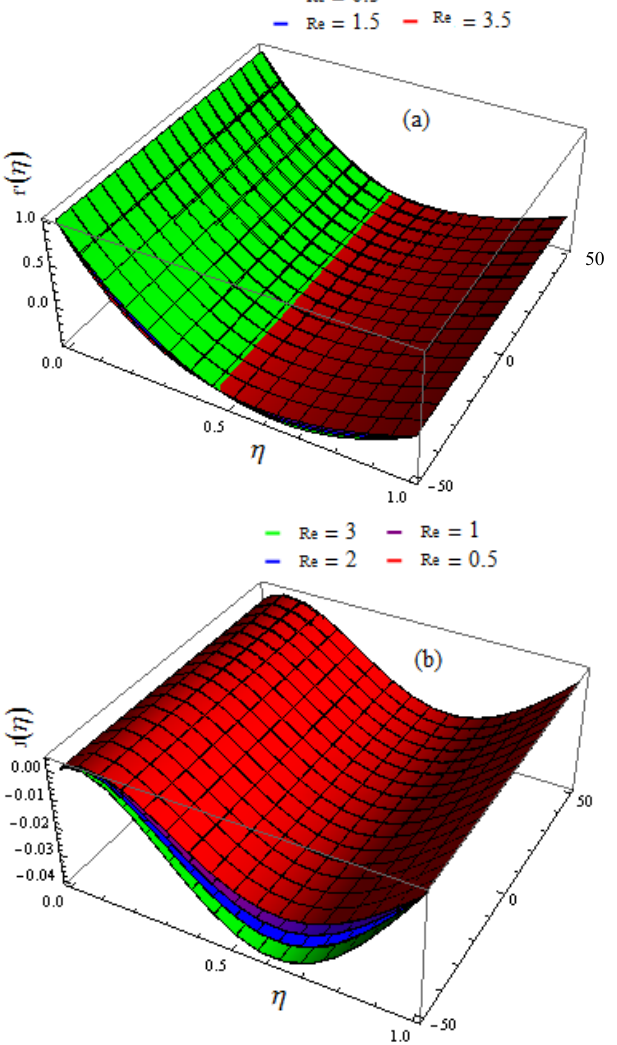
Figure 8. ( a ) Influence of Re on f (cid:48) ( η ) . ( b ) Influence of Re on J ( η ) Figure 8. ( a ). Influence of 𝑅𝑒 on 𝑓 ′ (𝜂) . ( b ) Influence of 𝑅𝑒 on 𝐽(𝜂) .